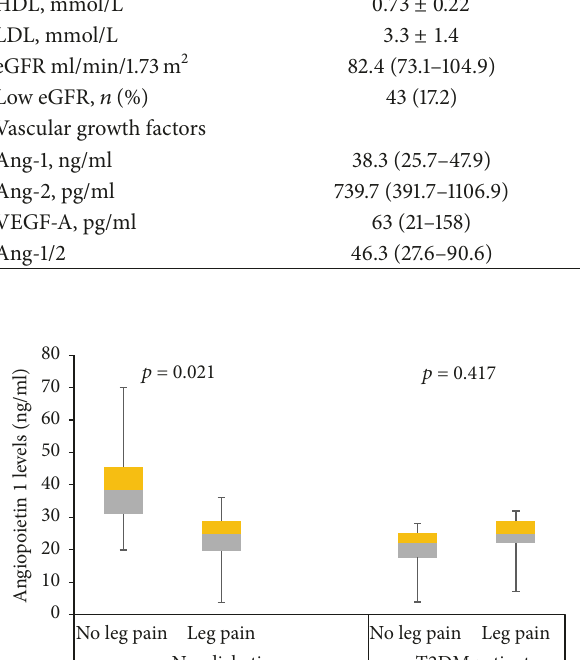
logistic regression model, but only Ang-2 remained signifi- cant after adjusting for various covariates (Table